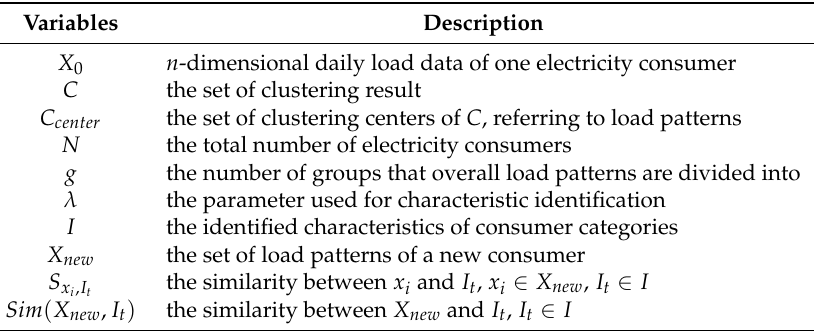
Table 1. Main variables used in the